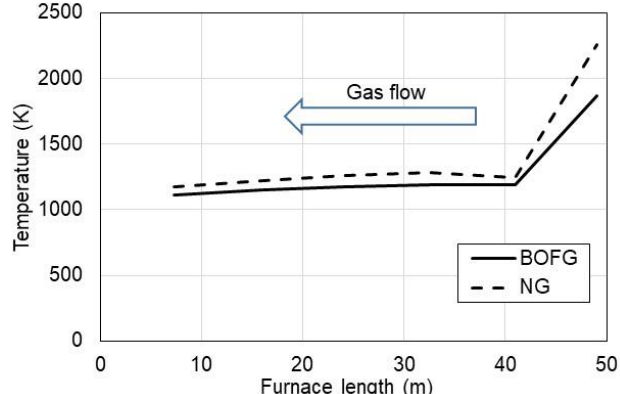
Figure 4. Exhaust gases temperature inside the tunnel furnace vs. length of this furnace fueled optionally with NG and BOFG.